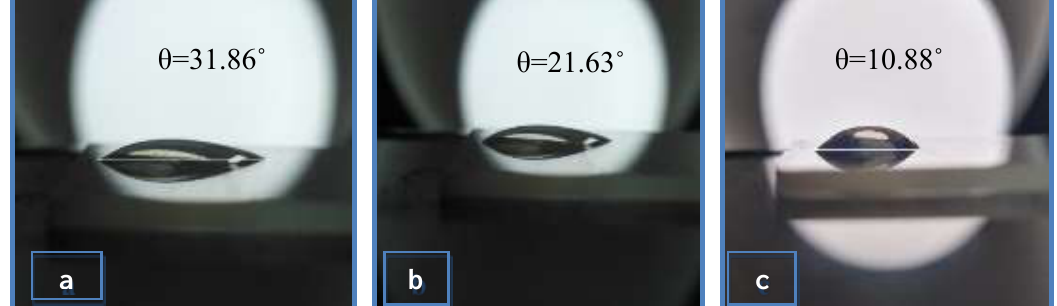
(Tm2): a-15min Vis irradiation, b- 2